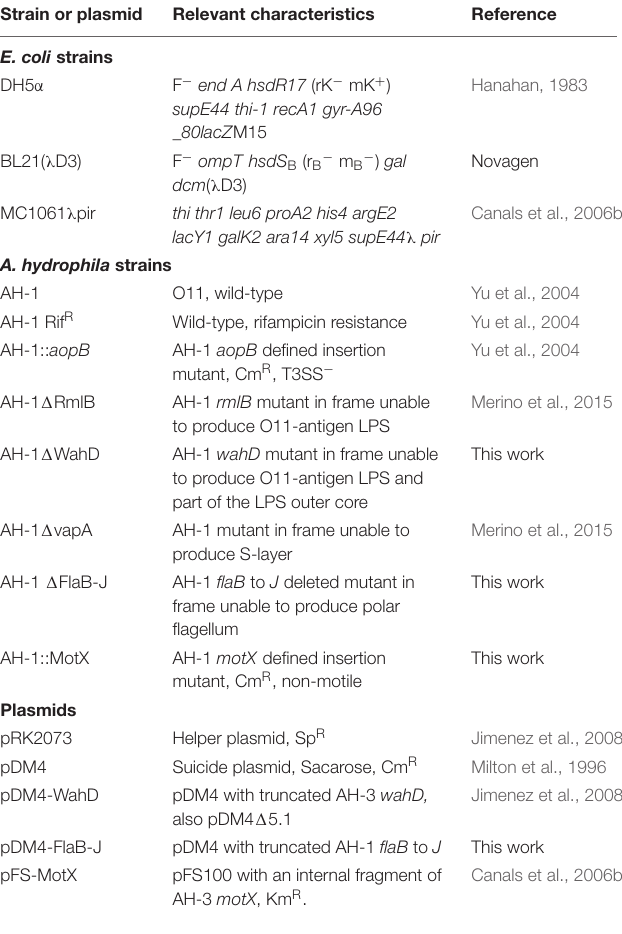
TABLE 1 | Bacterial strains and plasmids used in this